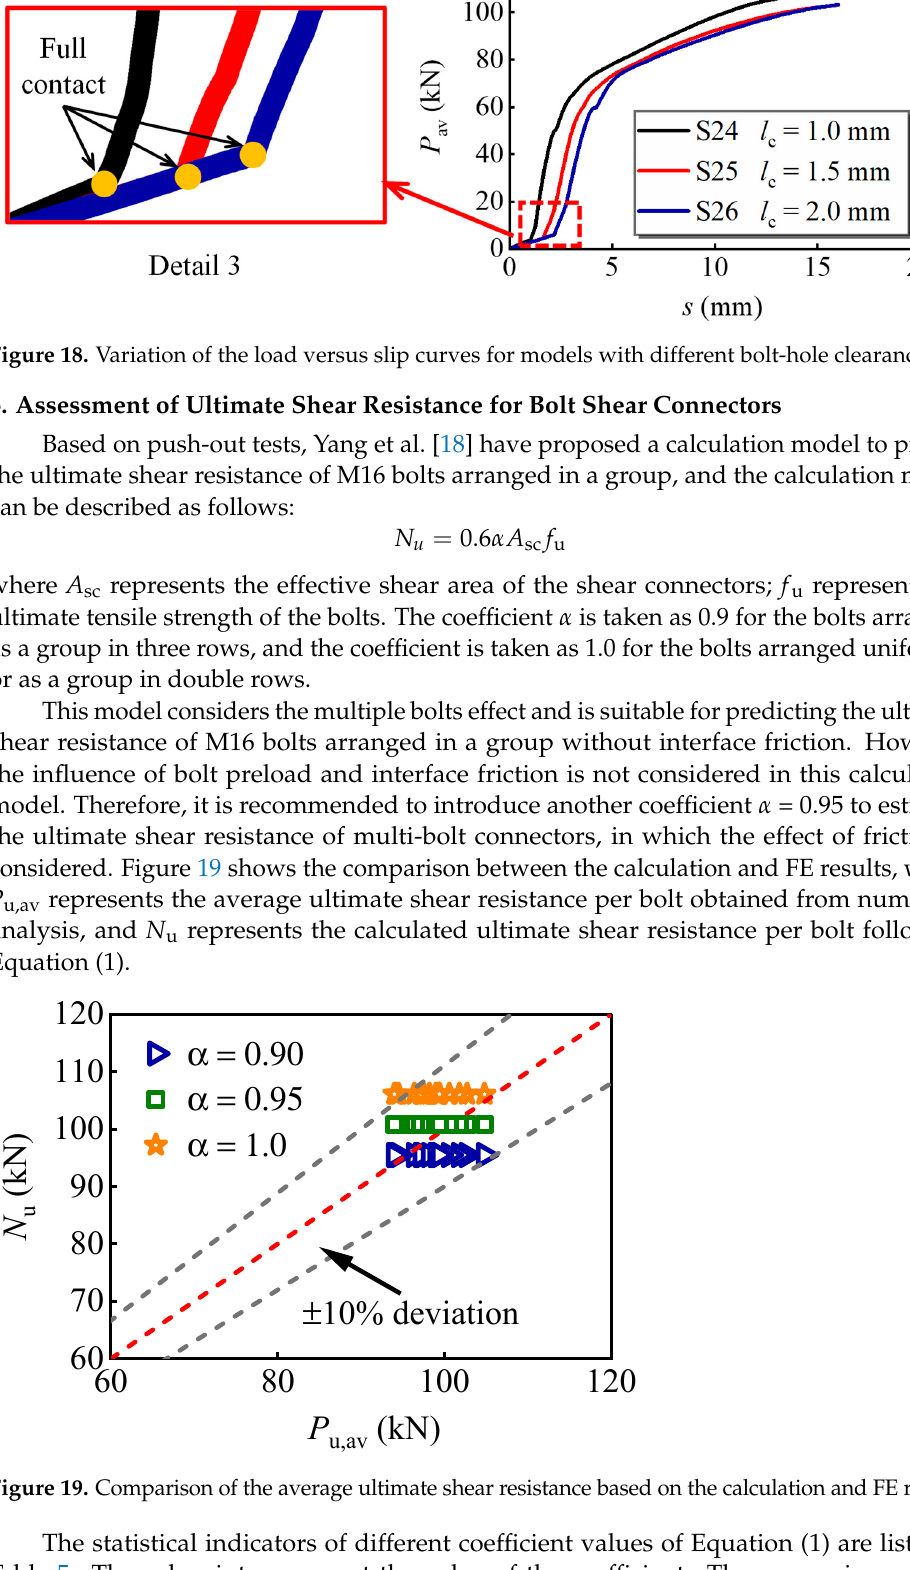
13 of 18 Figure 17. Average load versus slip curves for models with different slab depths. 4.2.8. Clearance between Bolt and Bolt Hole Figure 18 depicts the applied load versus slip curves with different bolt-hole clear-